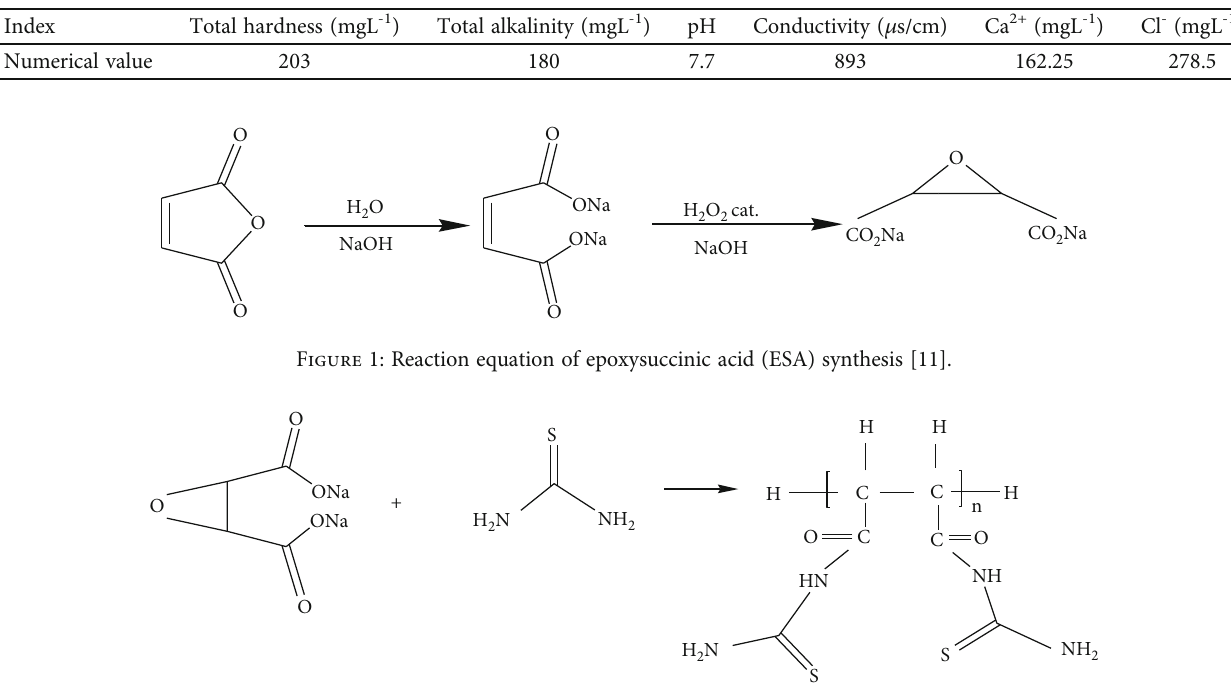
Table 1: Characteristics of water sample.